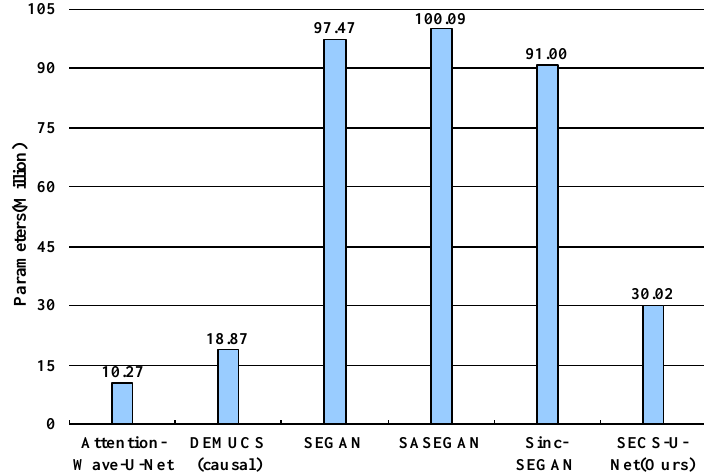
Figure 5. Comparison of parameters of SECS-U-Net and other reference methods.